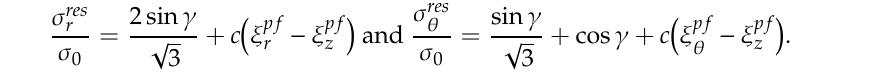
Figure 3. Distribution of the residual radial stress in an a = 0.4 cylinder.